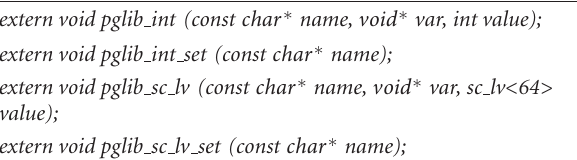
Table 2: Functions signagtures of the